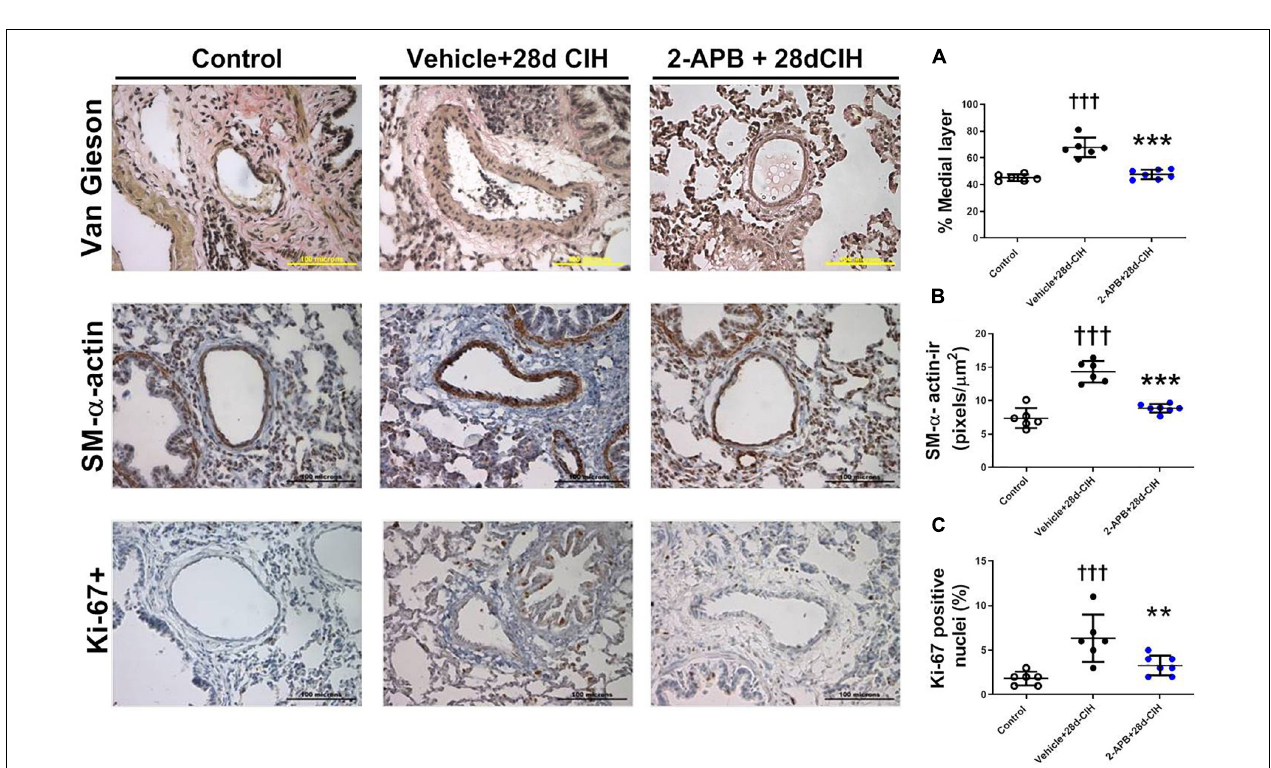
FIGURE 1 | Effect of 2-APB on right ventricular systolic pressure and heart rate in rats exposed to chronic intermittent hypoxia. 2-APB was infused from 14 days of CIH exposure with osmotic pumps at a rate of 10 mg/kg/day. (A) Right ventricular systolic pressure (RVSP) (ANOVA P = 0.0002). (B) Heart rate (HR) (ANOVA P = 0.41) in control (empty circles, n = 5), Vehicle + 28d-CIH (black circles, n = 5), and 2-APB + 28d-CIH rats (blue circles, n = 7). Mean ± SD. ††† P < 0.001 vs. all groups, *** P < 0.001 vs. Vehicle + 28d-CIH. One way ANOVA-followed by Newman Keuls tests.